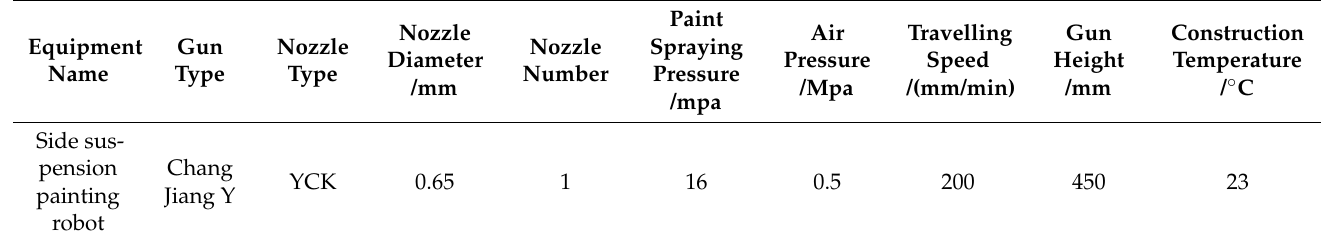
Table 11. Optimal painting parameters.